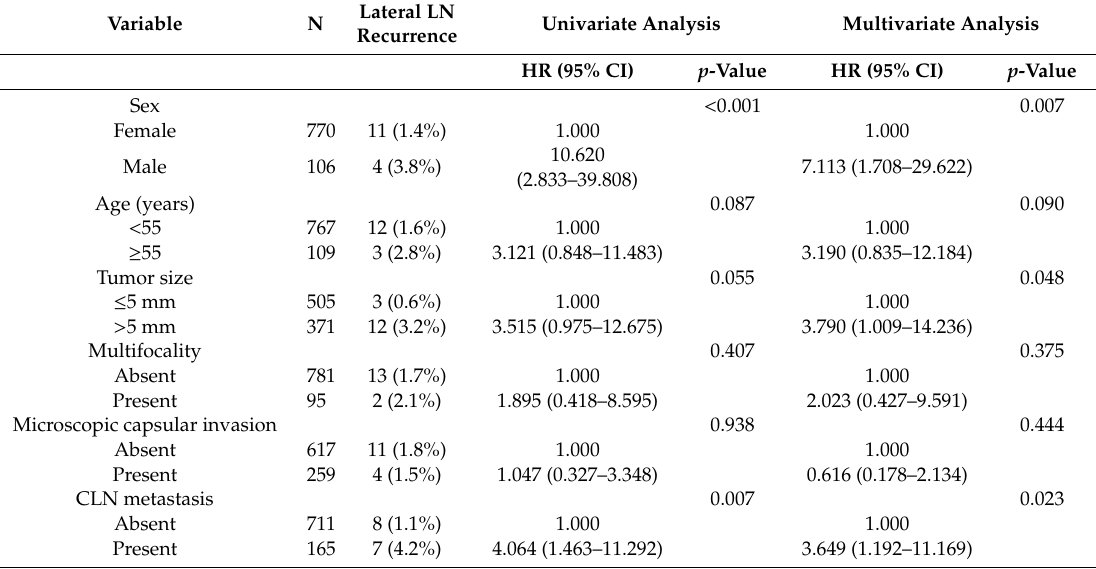
Table 3. Cox proportional hazard analysis of variables predicting recurrence of lateral neck lymph nodes after less than total